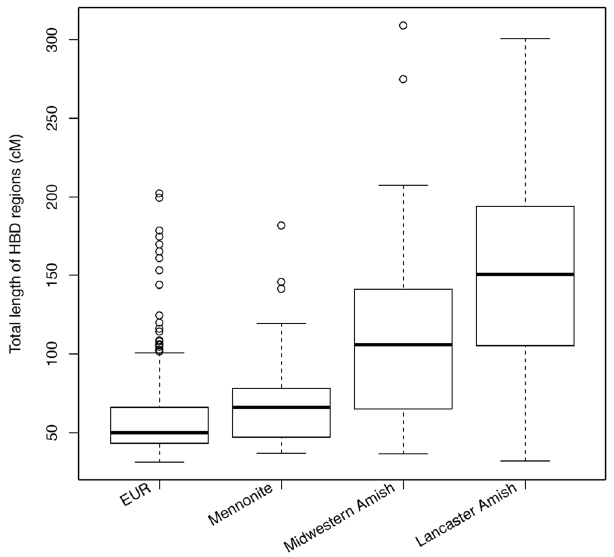
Figure 6. Reduced Genetic Diversity within Anabaptists. Total length of the genome homozygous by descent (HBD) within Europeans from the 1000G Project (EUR) and within various Anabaptist groups represented in the Phase I